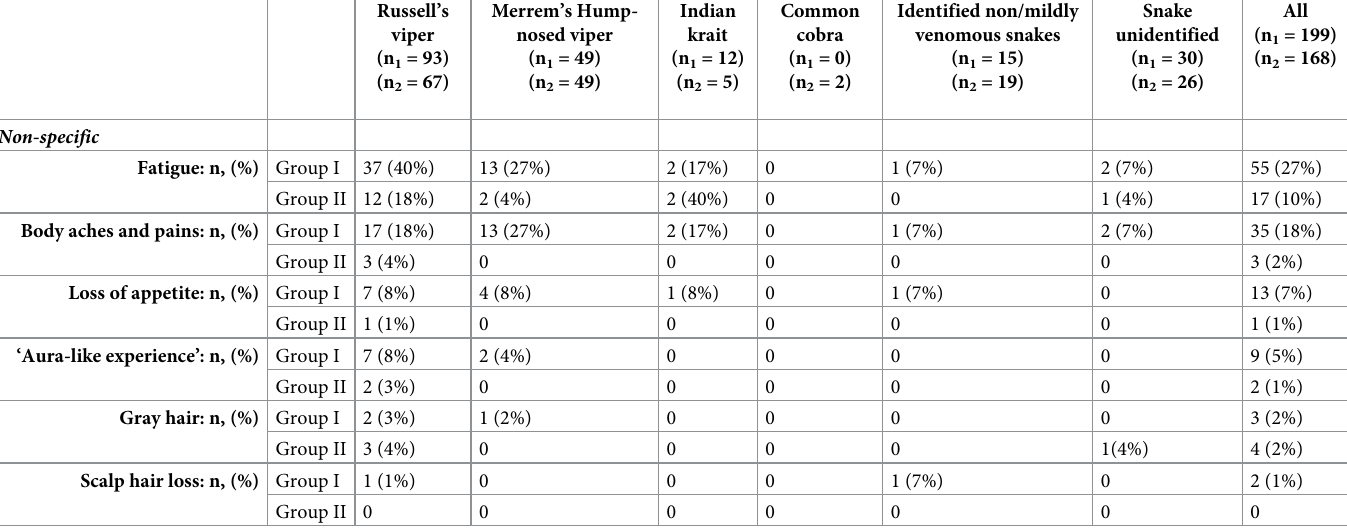
Table 3. Non-specific issues that could not be explained medically, complained by reviewed patients.